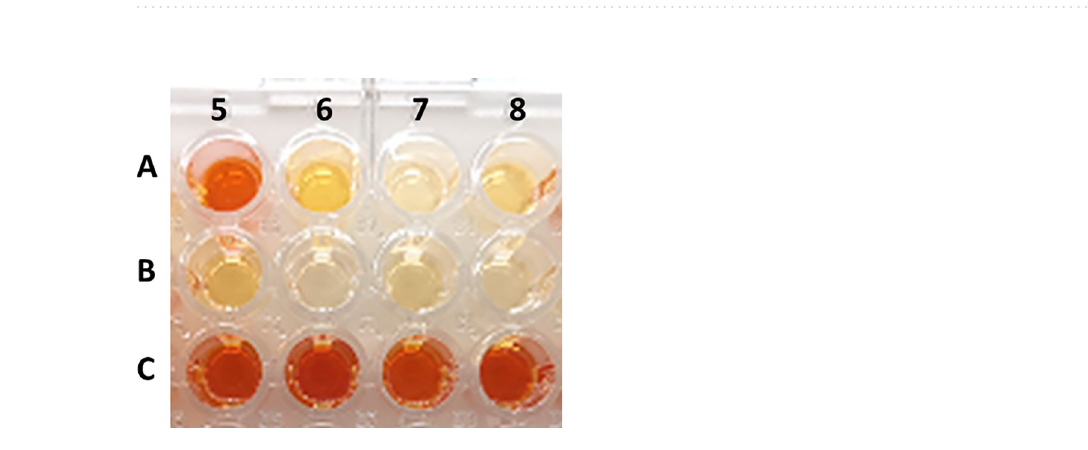
Figure 3. KRED assay at 24 h; A5: KP00104, A6: KP00127, A7: KP00128, A8: KP00129; B5: KP00138, B6: KP00139, B7: KP00140, B8: KP00141, C5: KP00150, C6: KP00151, C7: KP00152, C8: KP00153. Increased orange color intensity corresponds to higher absorbance values and consequently to a more active